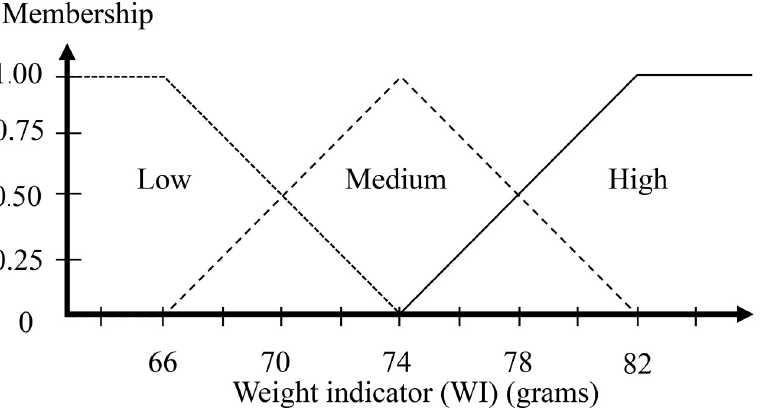
Fig 9. Input membership functions of the weight